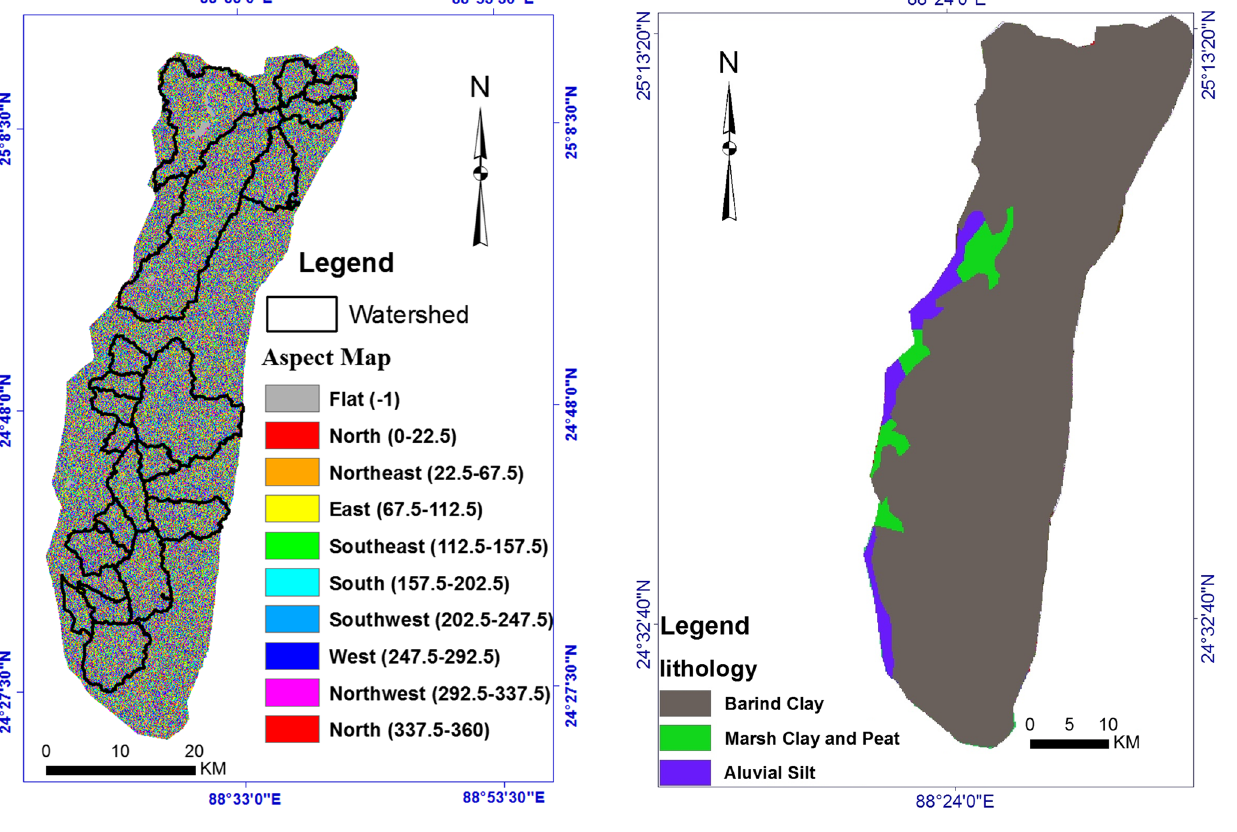
Fig. 4 Aspect map of the proposed area Fig. 5 Lithology map of the proposed